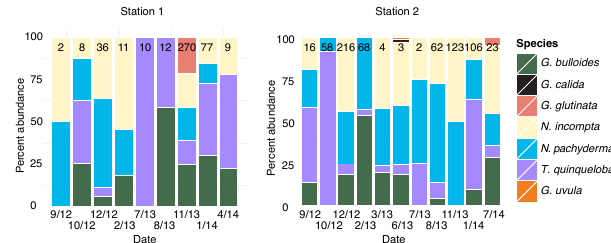
Figure 3. Relative abundance of all species at nearshore stations BL1 and BL2, with total number of foraminifera marked at the top of each bar.